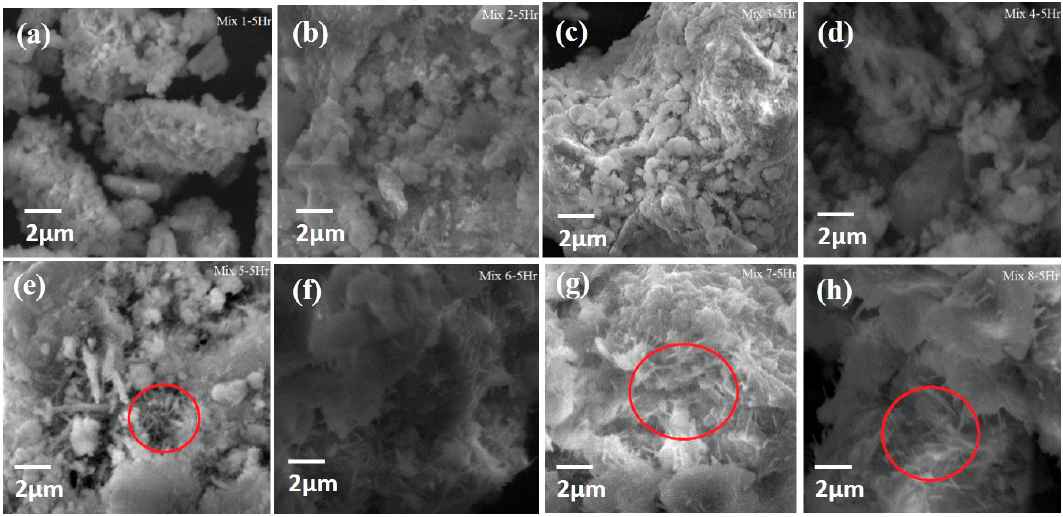
Figure 5. ( a – h ) SEM images represent the morphologies of Mixes 1 to 8 of hydration after 5 h.